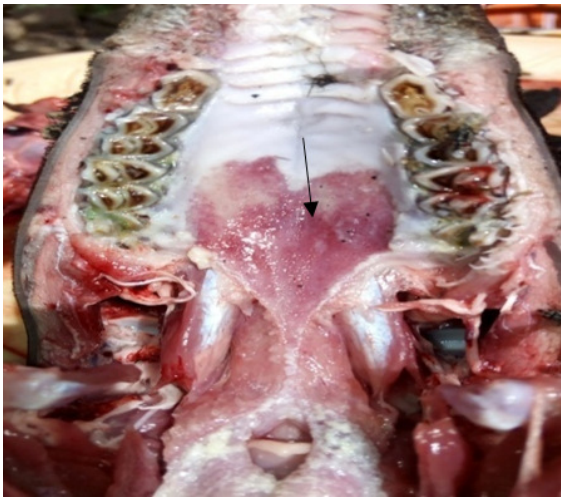
Fig. 3. Arrow pointing at the ulceration on the upper hard palate of a WAD goat suffering from PPR